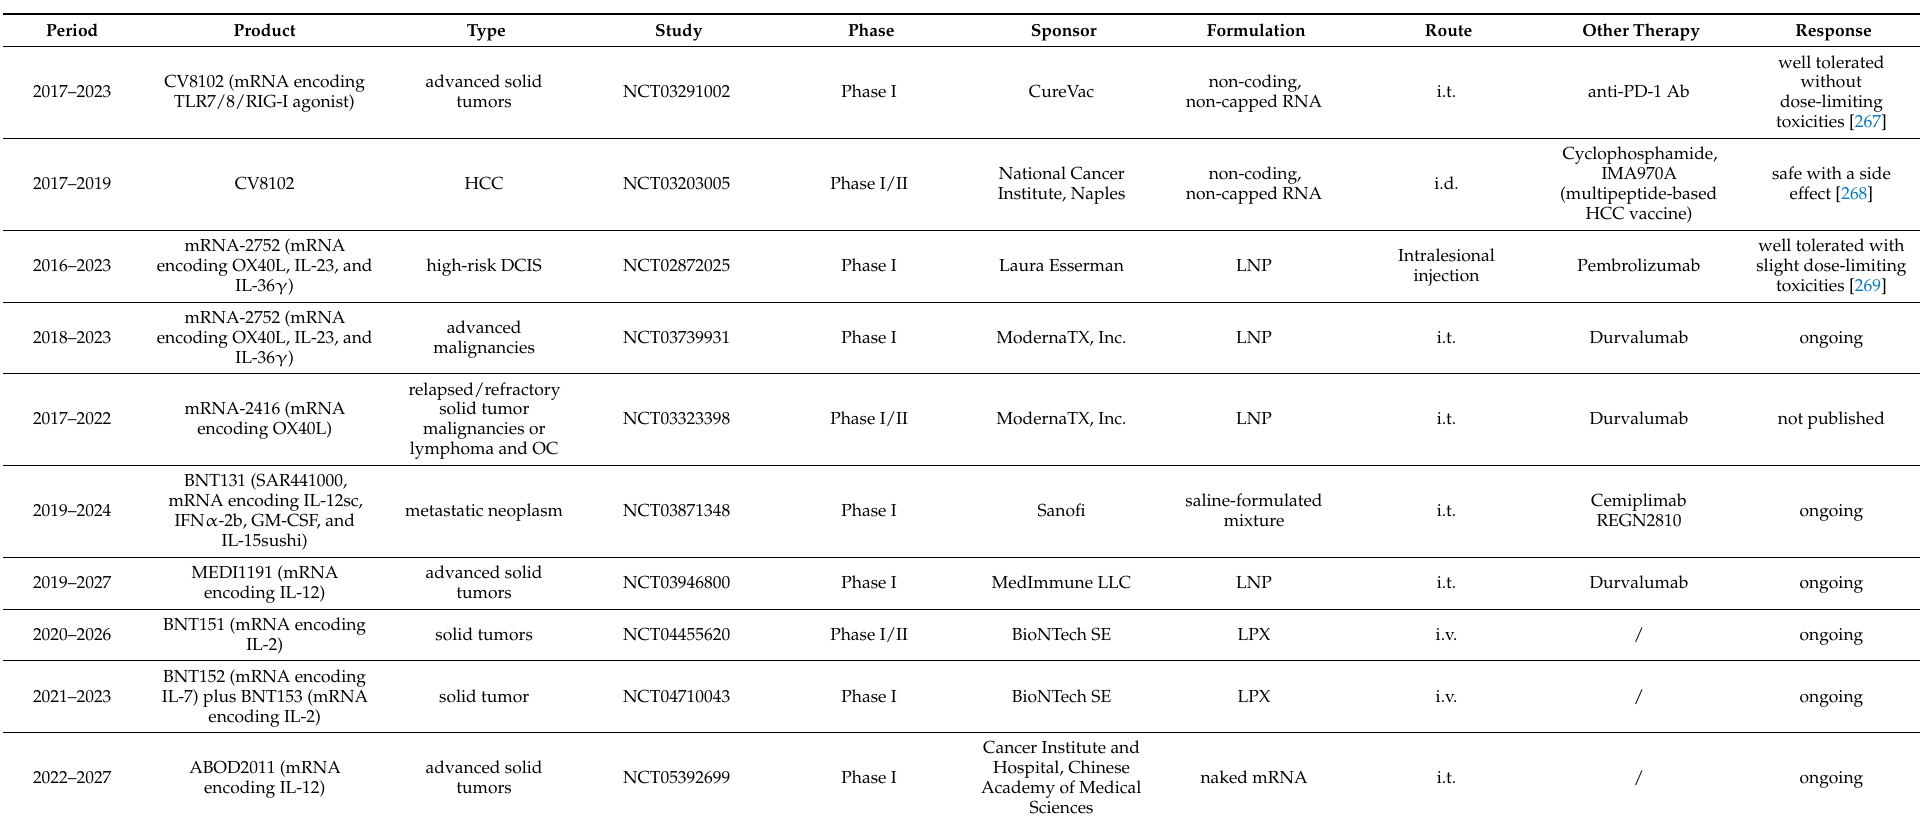
Table 6. Clinical trials of immunomodulator